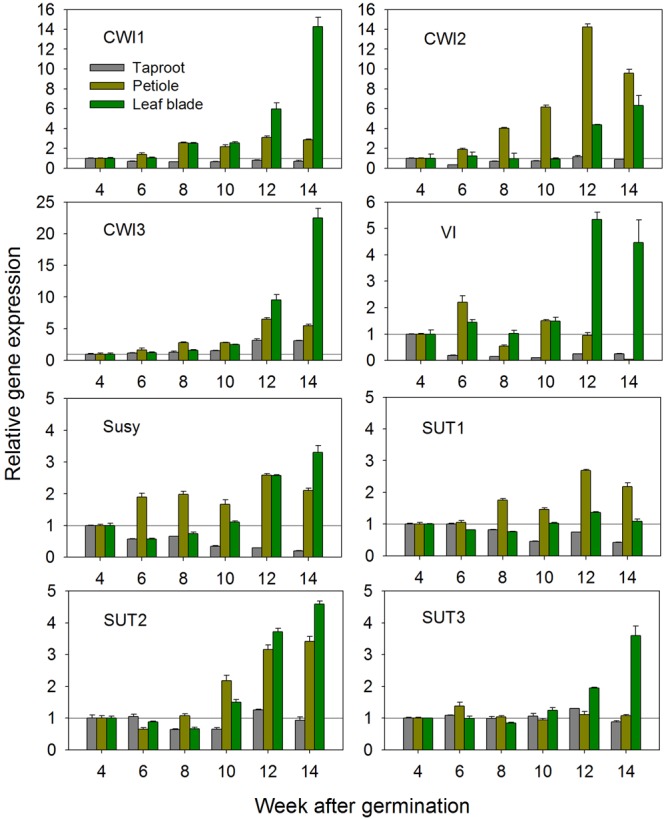
Transcript levels of cell wall invertase isoforms (CWI1-3), vacuolar invertase (VI), sucrose synthase (Susy) and sucrose transporter isoforms (SUT1-3) in leaf blades, petioles and taproots of chicory seedlings during a 14-week growth period. Transcript levels were determined by qPCR and normalized against the expression of two reference genes (Actin and RPL19). Transcript levels in different plant organs were expressed relative to the levels of 4-week-old seedlings, which were arbitrarily set to 1 as indicated with a horizontal line.